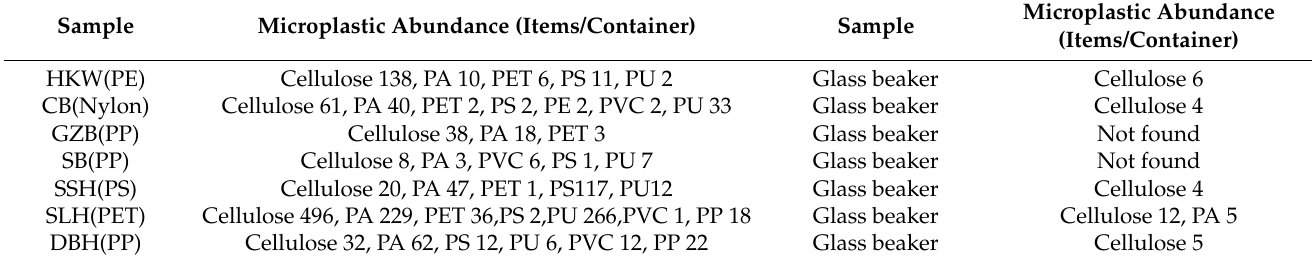
Table 2. Microplastic abundance in take-out containers and glass